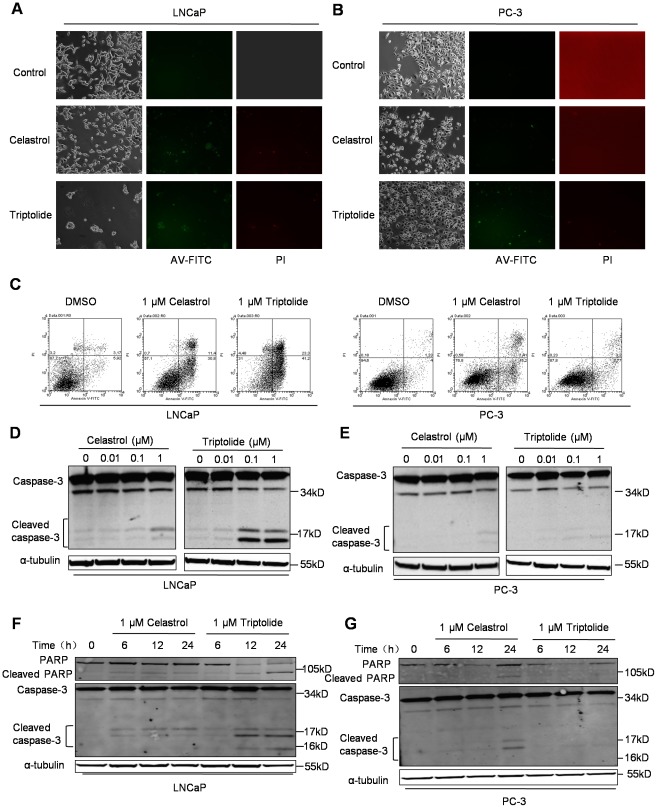
Triptolide and Celastrol induce apoptosis in PCa cells in vitro.(A) and (B) Fluorescence microscopy observation of Triptolide- and Celastrol- induced apoptosis in LNCaP (A) and PC-3 (B) cells. After treatment with 1 µM Celastrol or Triptolide for 24 h, LNCaP and PC-3 cells were incubated with AV-FITC (green) and PI (red). Representative bright field and fluorescent images are shown. (C) Flow cytometric detection of apoptosis in LNCaP and PC-3 cells treated as above. Percentage of intact cells (AV−/PI−), early apoptotic cells (AV+/PI−), late apoptotic/necrotic cells (AV+/PI+) and necrotic cells (AV−/PI+) are presented. (D) and (E) Western blot analysis of caspase-3 protein in Triptolide- or Celastrol-treated LNCaP (D) and PC-3 (E) cells. Cells were treated with indicated concentrations of Triptolide or Celastrol for 24 h and subjected to analysis. Uncleaved caspase-3 and cleaved products are indicated. α-tubulin was used as a loading control. (F) and (G) Western blot analysis of PARP and caspase-3 proteins in Triptolide- or Celastrol-treated LNCaP (F) and PC-3 (G) cells. Cells were treated with 1 µM Triptolide or Celastrol for desired times. Uncleaved PARP and caspase-3 and their cleaved products are indicated. α-tubulin was used as a loading control.